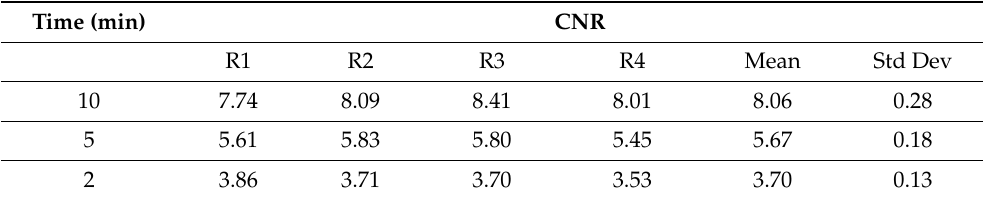
Table 3. Contrast-to-noise ratios for the repeatability dataset (12 PET images). Time = acquisition time (per bed position), R = reconstruction, CNR = contrast-to-noise ratio according to Equation (1). Time (min) CNR R1 R2